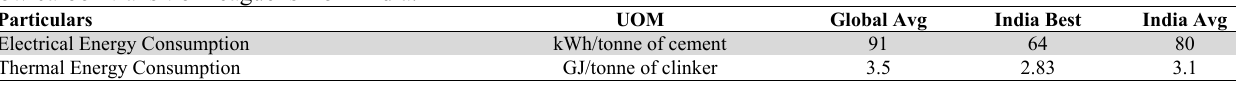
Low carbon transition league is from India.